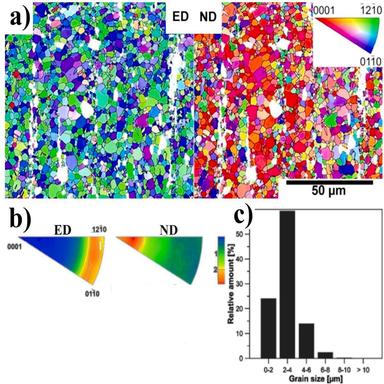
a) IPF maps evaluated from the EBSD data acquired from the longitudinal section of the extruded Zn-0.8Mg-0.2Sr alloy and evaluated for both ED and ND. The white areas correspond to the intermetallic phases. The vertical direction of the figures corresponds to the direction of the extrusion. b) Inverse pole figures for ED and ND. c) A histogram showing the grain size distribution.